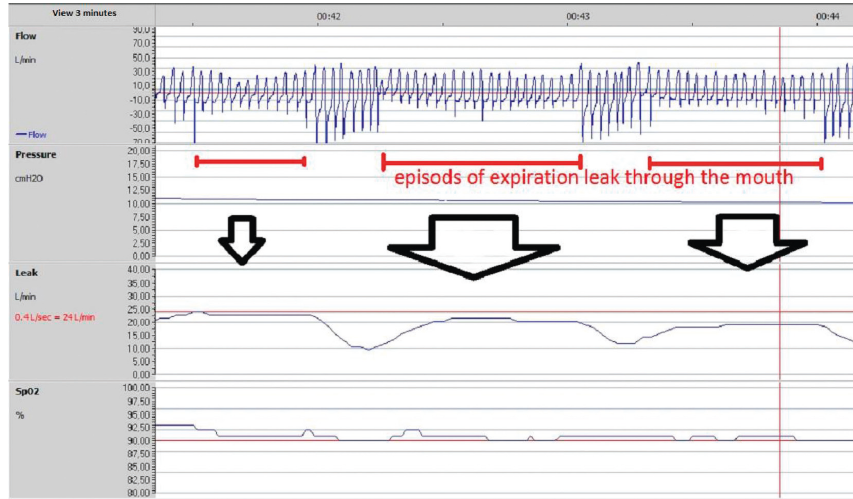
Figure 8: A 3-minute recording of CPAP therapy showing three episodes of expiration leak through the mouth. The respiration flow.